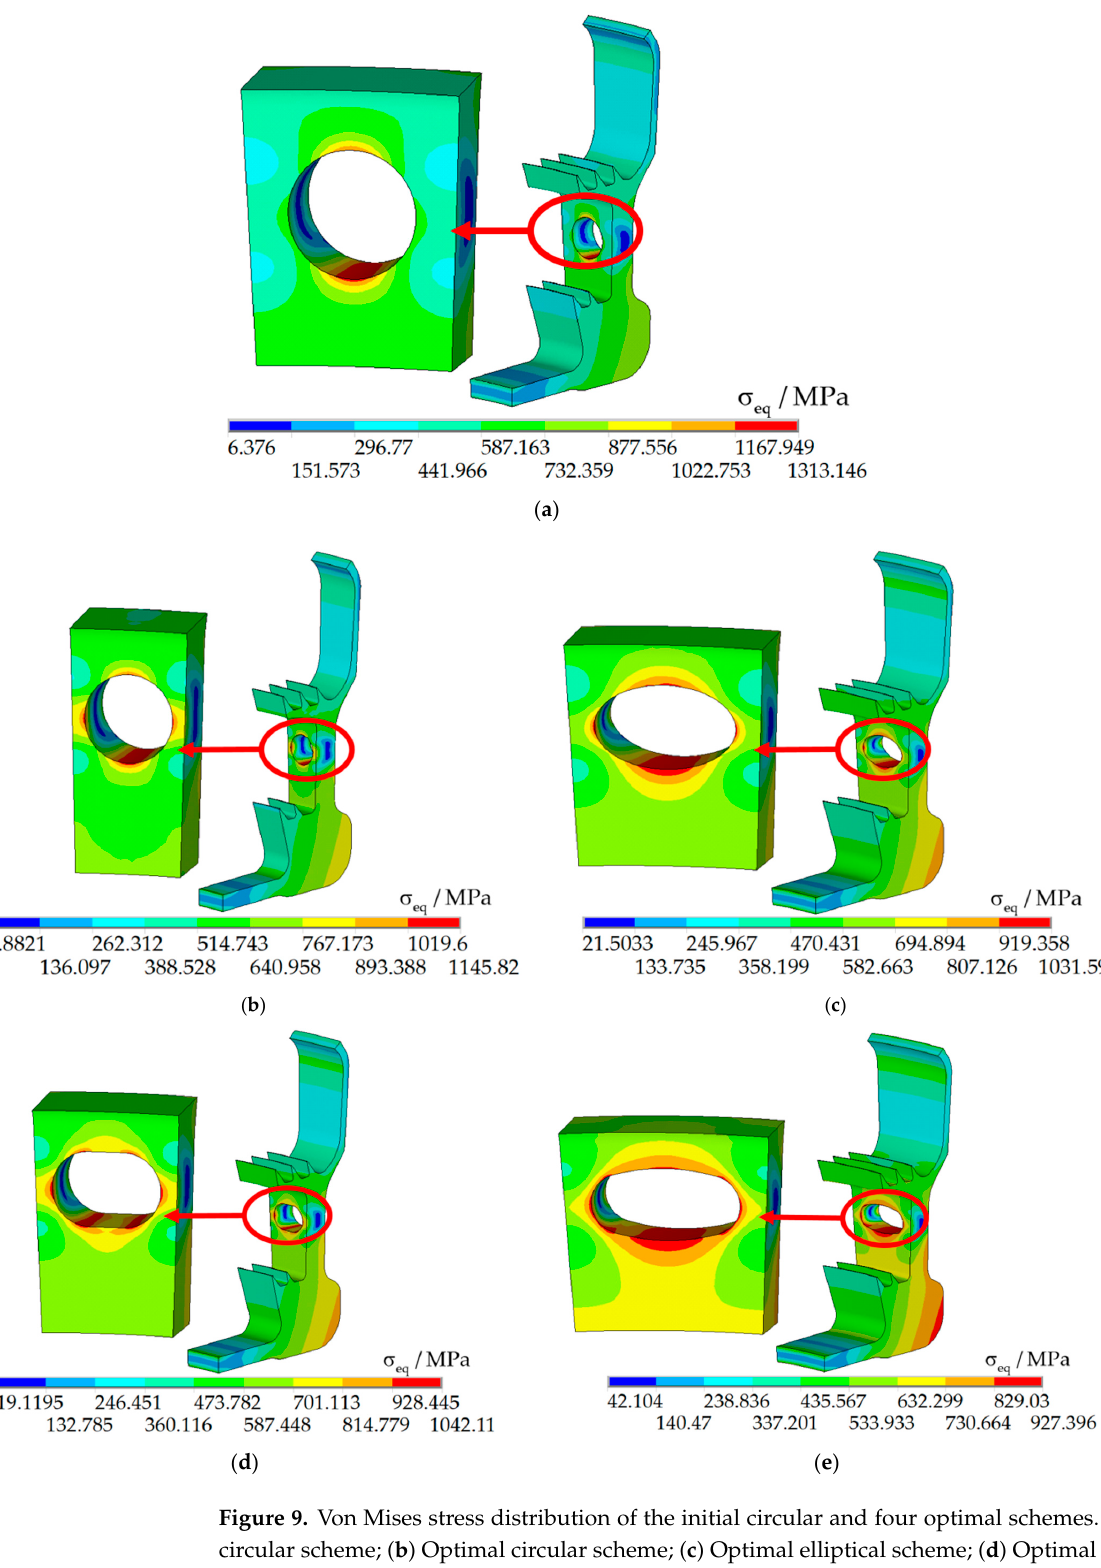
Figure 9. Von Mises stress distribution of the initial circular and four optimal schemes. ( a ) Initial circular scheme; ( b ) Optimal circular scheme; ( c ) Optimal elliptical scheme; ( d ) Optimal race-track scheme; ( e ) Optimal four-arc scheme.